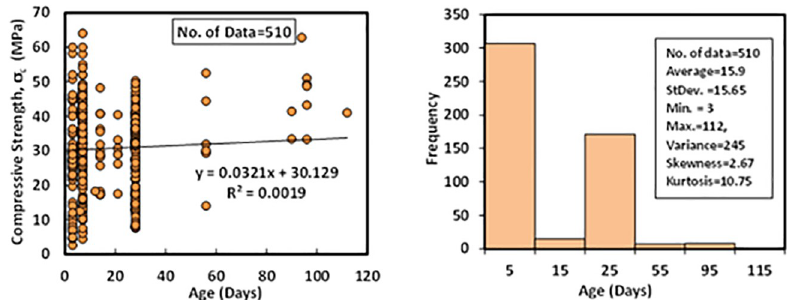
Fig 13. Variation between compressive strength and curing duration histogram of fly ash-based geopolymer concrete mixtures.